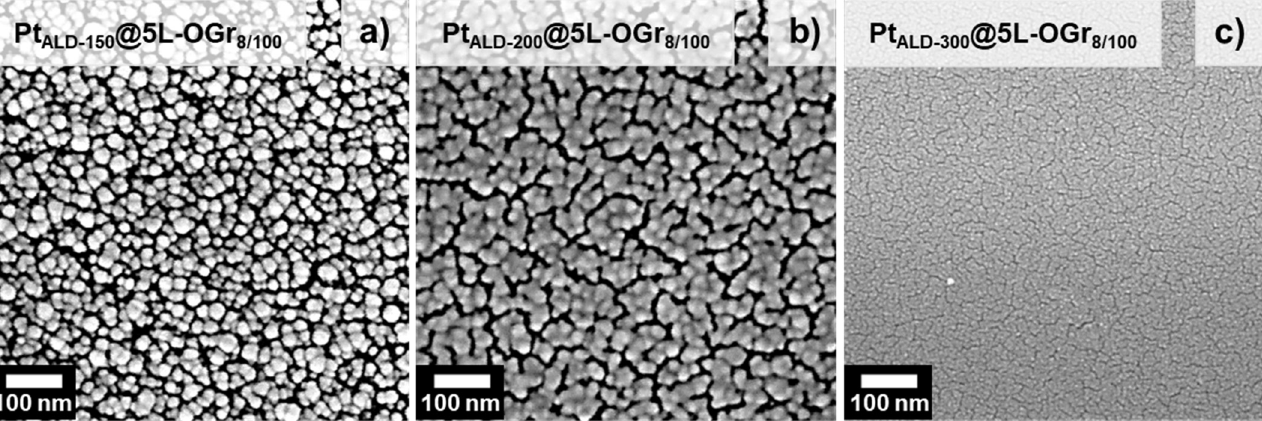
Figure 3. SEM images of 5L-OGr 8/100 samples after ( a ) 150 ALD cycles, ( b ) 200 ALD cycles, ( c ) 300 ALD cycles. All the platinum-decorated oxidized graphene samples are transferred onto a silicon wafer using PMMA and ammonium persulfate as an etchant.